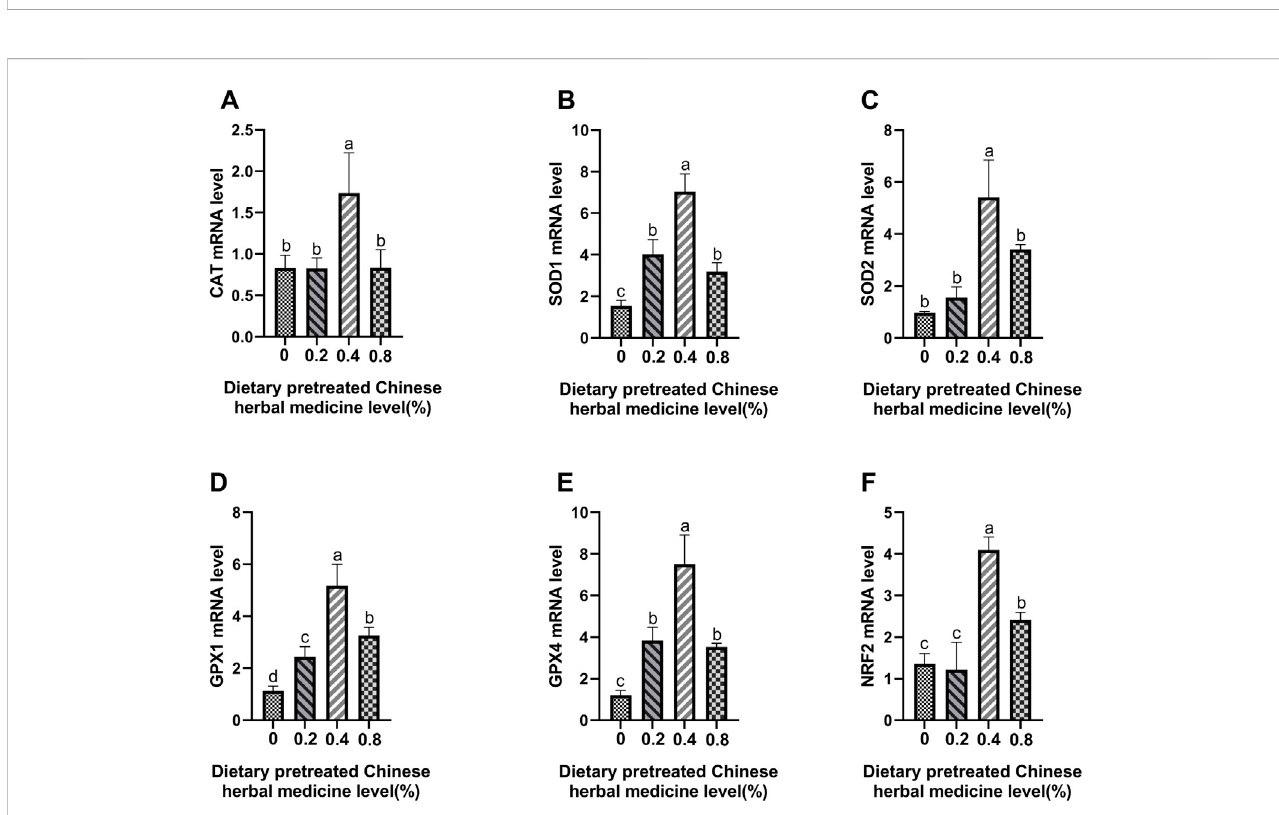
FIGURE 6 Effects of dietary PCHM supplementation on antioxidation-related mRNA expression in liver. The effect of adding PCHM (0, 0.2%, 0.4%, 0.8%) in diets in the liver, measured by quantitative PCR: (A) CAT , (B) SOD1 , (C) SOD2 , (D) GPX1 , (E) GPX4 , and (F) Nrf2 . Values are expressed as means ± SEM of six birds per treatment. Means without a common letter differ ( p <